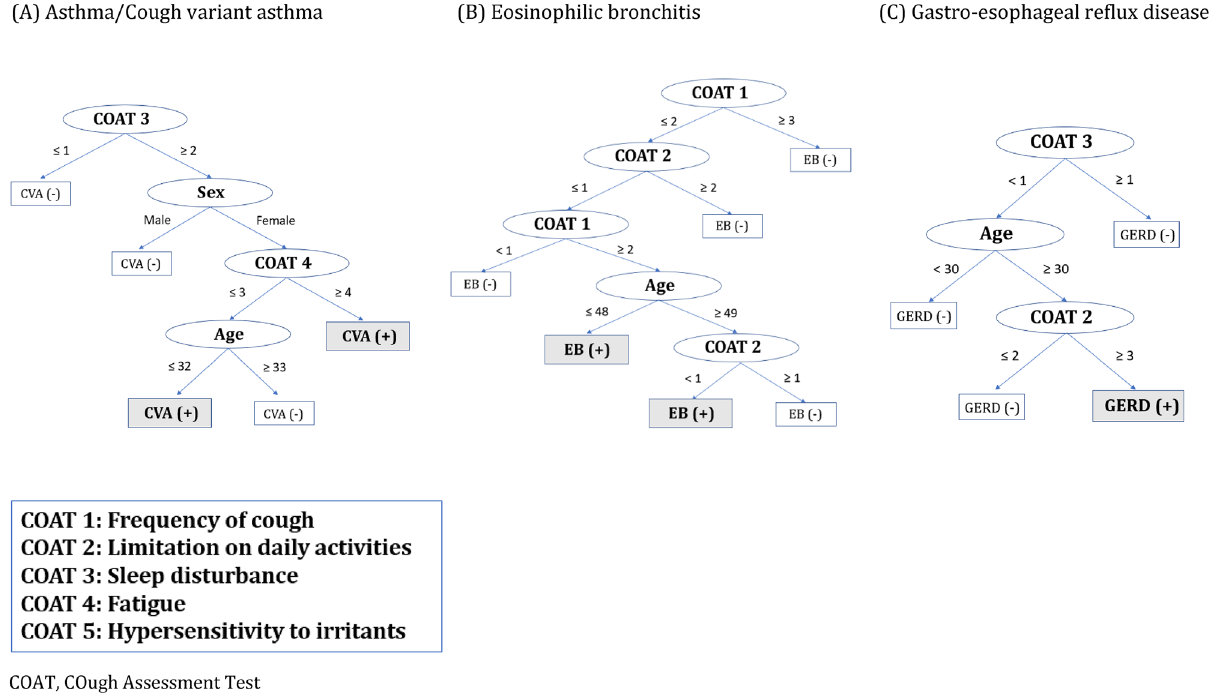
Figure 3. Decision tree for ( A ) asthma/cough variant asthma, ( B ) eosinophilic bronchitis, and ( C ) gastroesophageal reflux disease using COAT questionnaire. COAT COugh Assessment